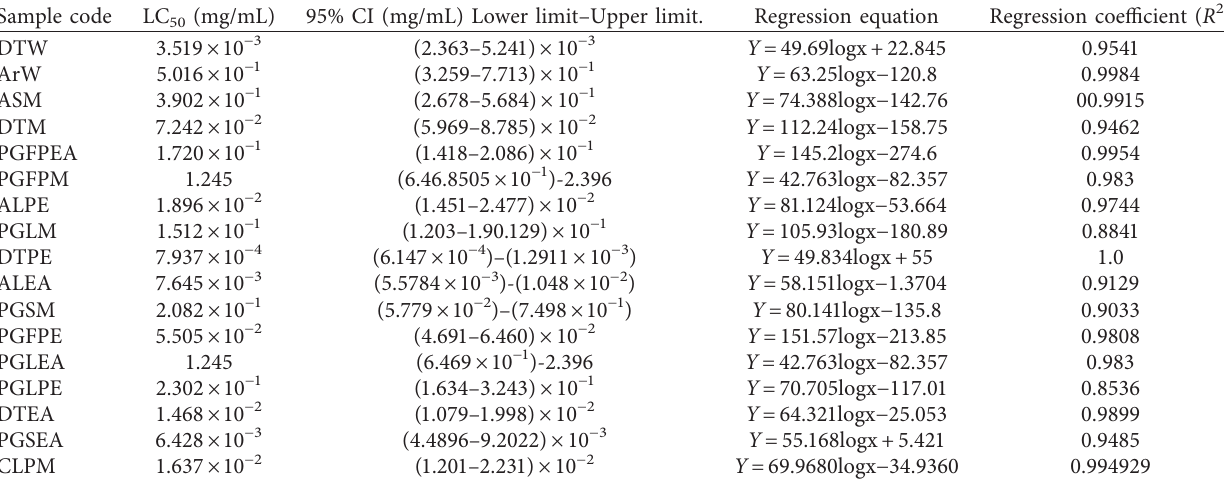
Table 2: Results of brine shrimps lethality test against plant extracts. Sample